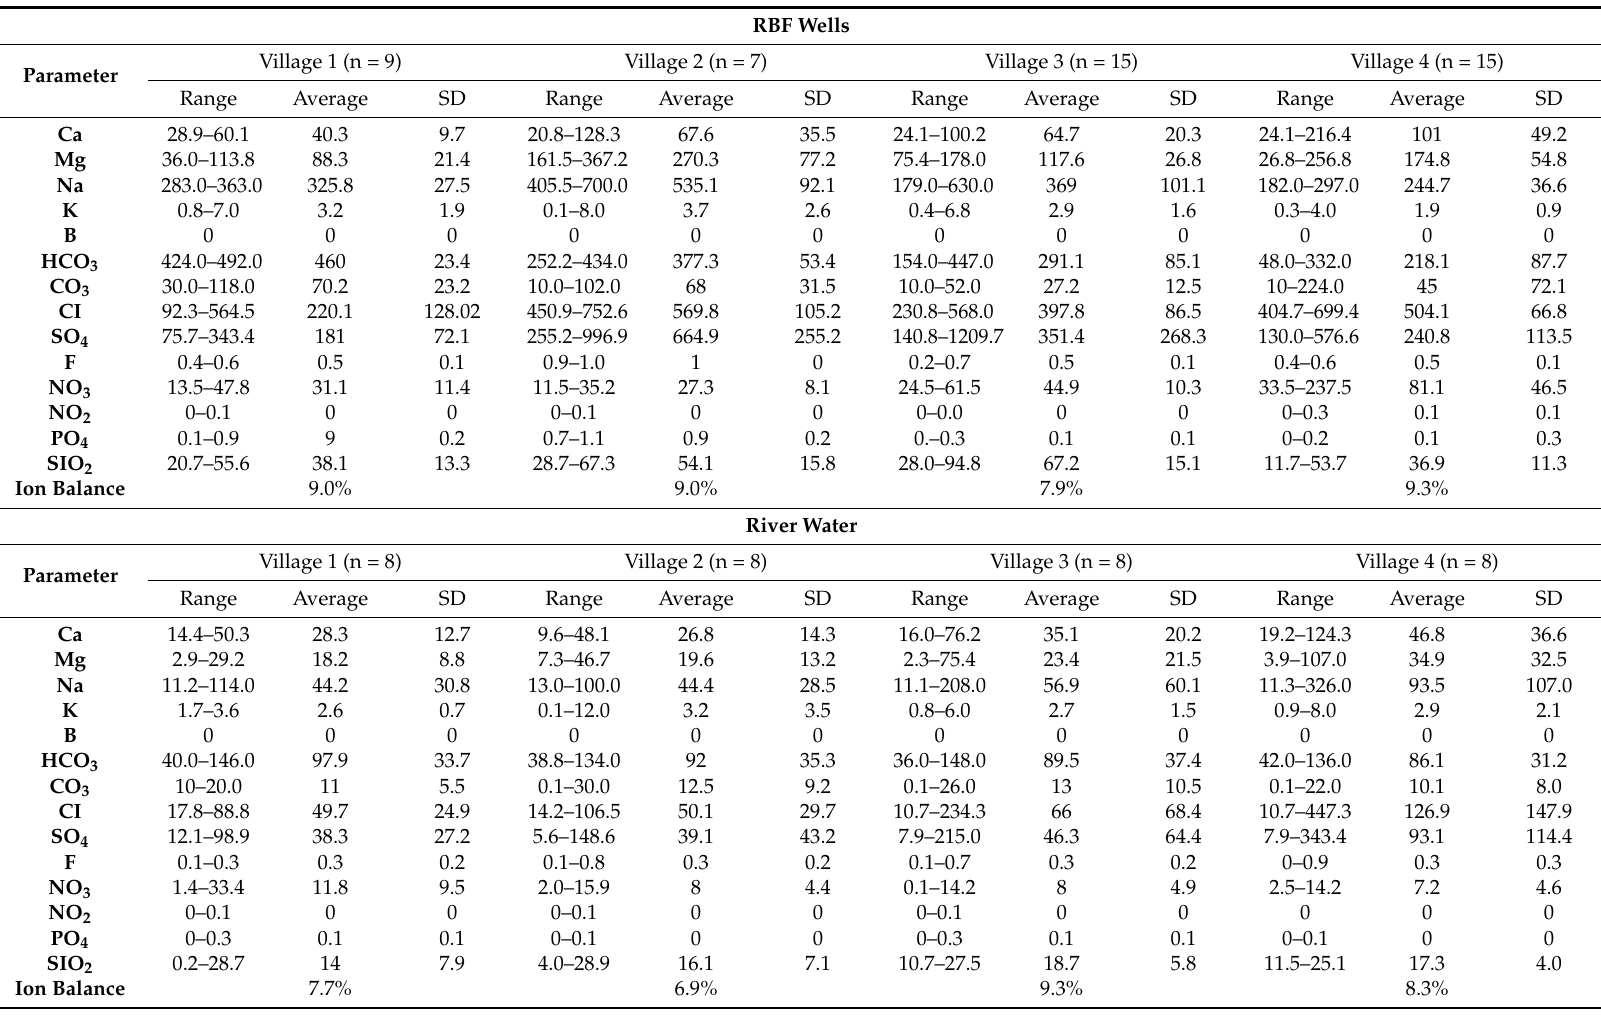
Table 3. Ranges, averages (arithmetic means), and means of major cation and anion analysis, including dissolved silicate and ion balance in RBF and river water samples. All concentrations are in